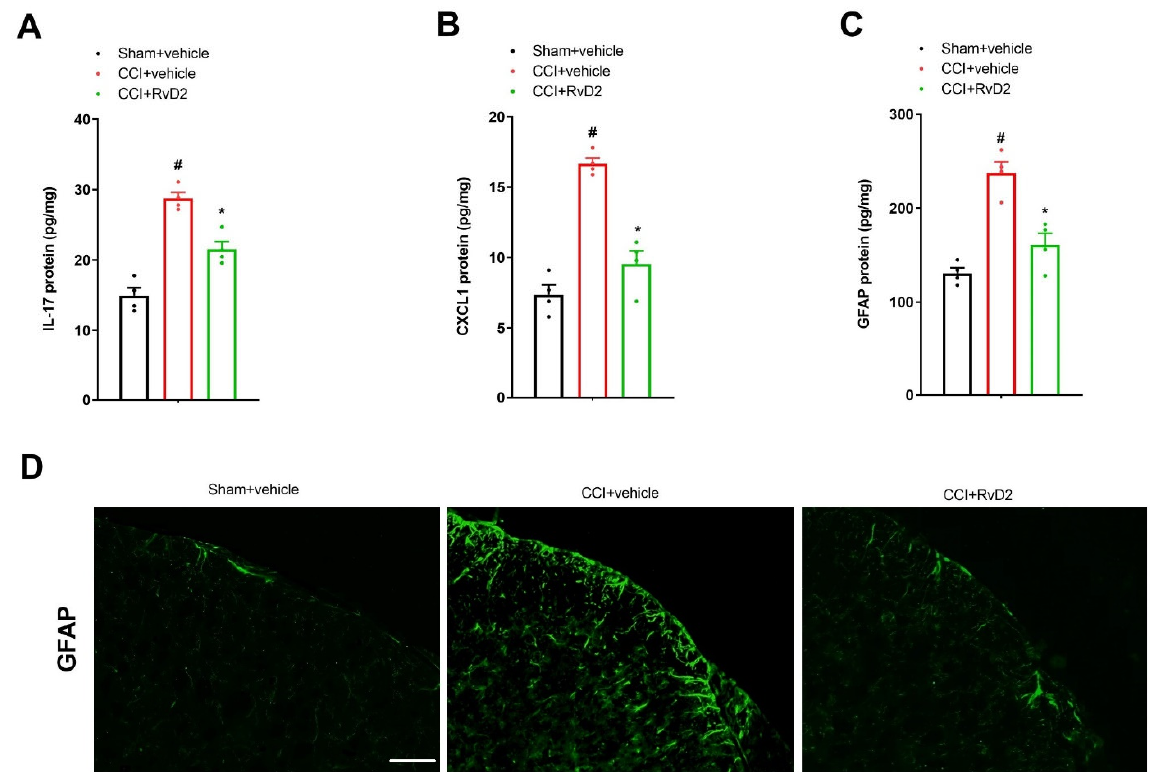
Figure 2. Pretreatment with RvD2 reduced spinal IL ‐ 17 secretion, CXCL1 release and astrocyte activation following peripheral nerve trauma. Intrathecal RvD2 (500 ng) was administered daily on days 4, 5 and 6 following CCI operations. All biochemical data were collected on day 7 following sham and CCI interventions. ( A – C ) ELISA assays showed that RvD2 pretreatment down ‐ modulated the elevated levels of spinal IL ‐ 17, CXCL1 and GFAP (the marker of astrocyte activation) proteins in CCI animals. ( D ) Immunohistochemistry staining showed representative photomicrographs of GFAP in the spinal dorsal horn following CCI surgeries and RvD2 exposure (scale bar, 50 μ m). Results from biochemical experiments are presented as the mean ± SEM ( n = 4) and compared using one ‐ way ANOVA followed by Bonferroni multiple comparisons. # p < 0.05 vs. group sham + vehicle. * p < 0.05 vs. group CCI + vehicle.